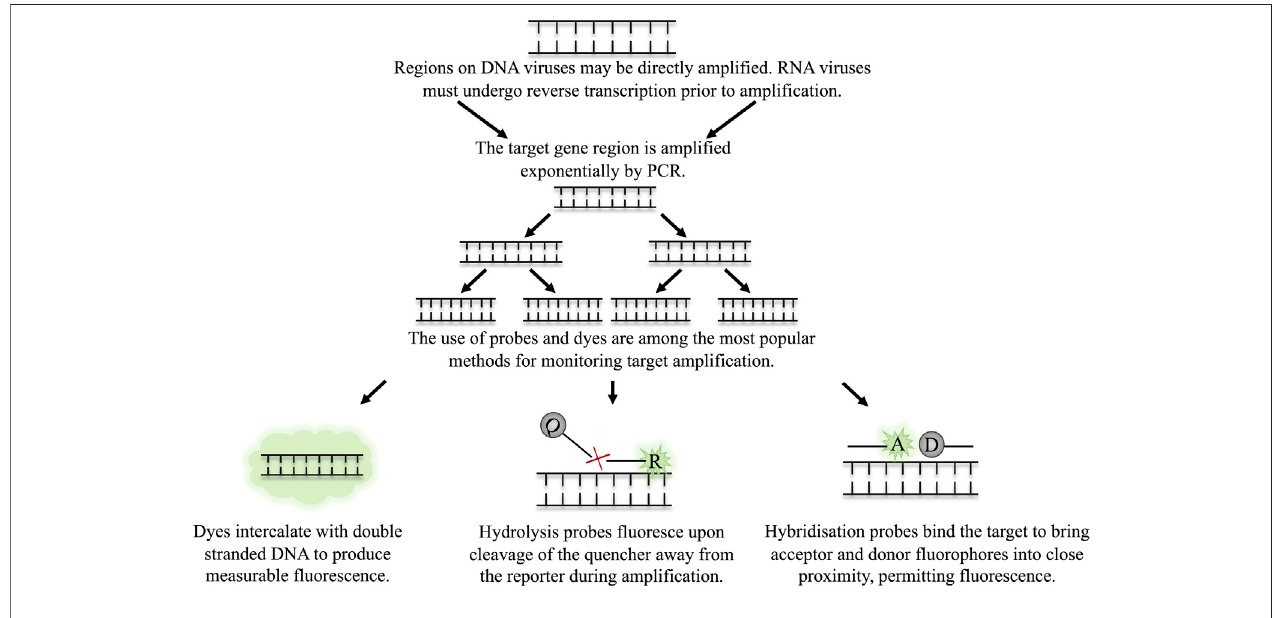
FIGURE 2 | The detection of target amplicon in qPCR through dyes and probes. The target region on the virus is ampli fi ed by multiple rounds of exponential ampli fi cation in PCR. During ampli fi cation, various methods are employed to monitor the real time production of target DNA. (A) Dyes intercalate indiscriminately with double stranded DNA, causing an increase in fl uorescence as the level of double stranded DNA in the sample increases. Hydrolysis and hybridisation probes require bindingto aspeci fi csequence on the target amplicon topermit fl uorescence.Fluorescence isachieved eitherby cleavage oftheprobe when employinghydrolysis probes (B) , or through binding of the probes to the target region in close proximity to one another, as is the case for hybridisation probes (C)